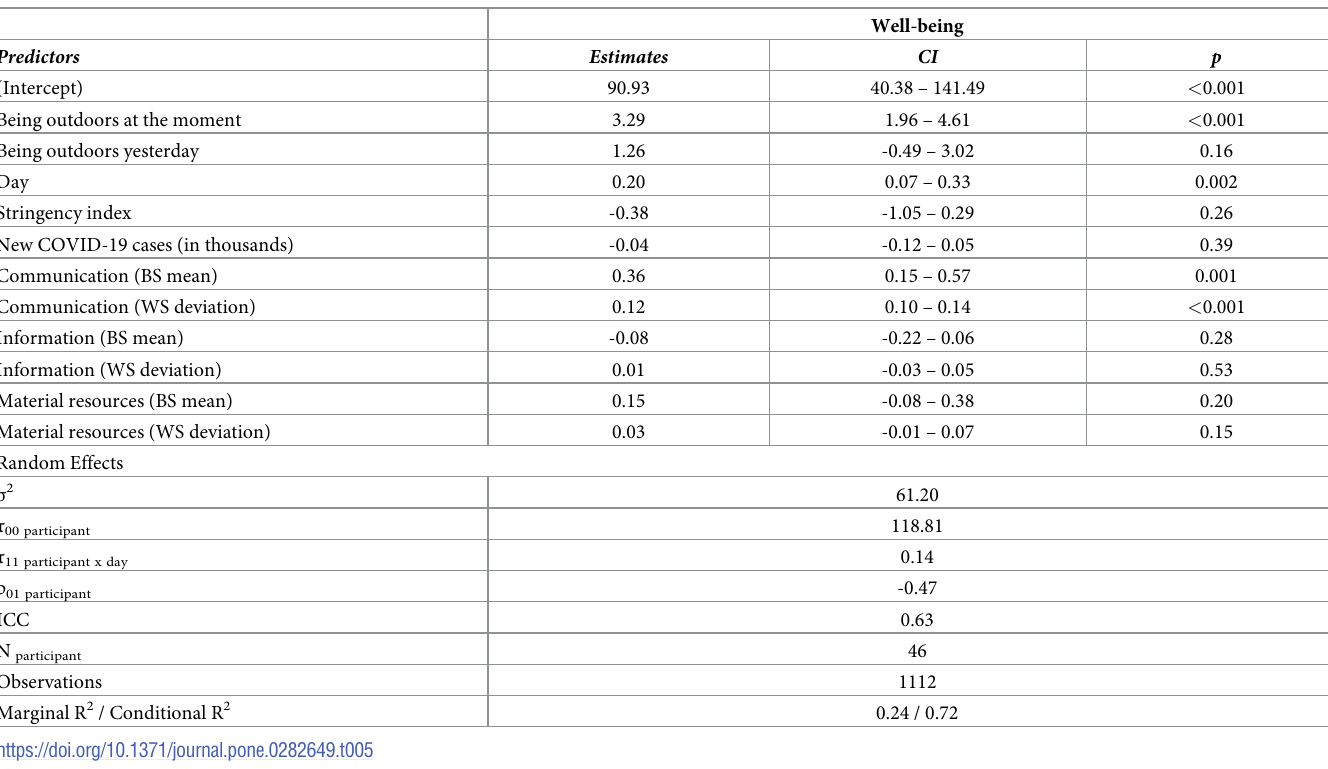
Table 5. Regression coefficients for well-being score.